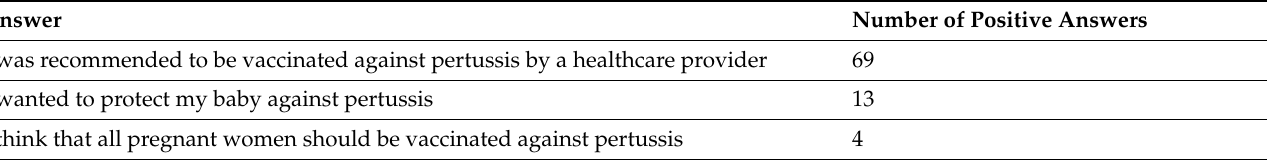
Table 6. Main reason to be vaccinated against pertussis—86 patients who accepted Tdap after refusing flu shot. Answer